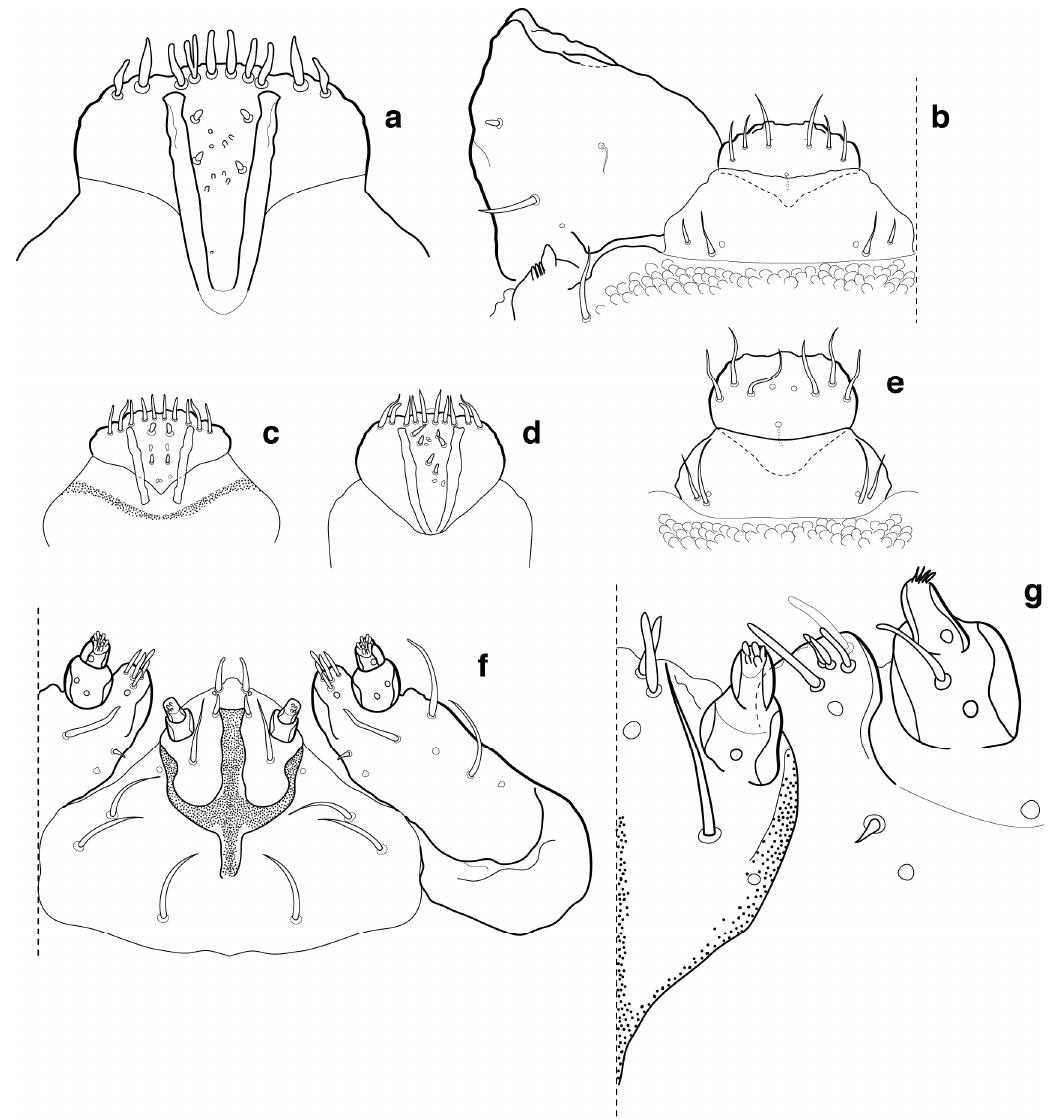
Figure 82. Sitophilus spp. mouthparts: ( a ) Sitophilus granarius epipharynx; ( b ) Sitophilus linearis , labrum, clypeus, mandible, antenna and anterior margin of frons; ( c ) Sitophilus linearis , epipharynx; ( d ) Sitophilus oryzae , epipharynx; ( e ) Sitophilus oryzae , labrum, clypeus, and anterior margin of frons; ( f ) Sitophilus linearis , labio-maxillary complex, ventral view; and ( g ) Sitophilus granarius detail, mala and labium, ventral view.